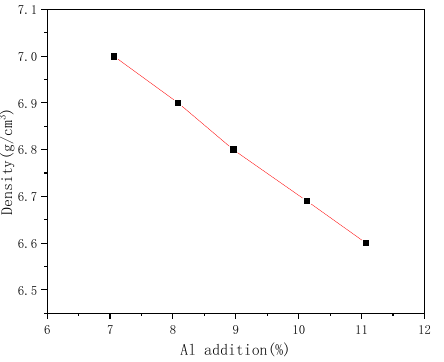
Figure 1. Effect of Al addition on the density reduction of Fe-30Mn-xAl-1C steel.